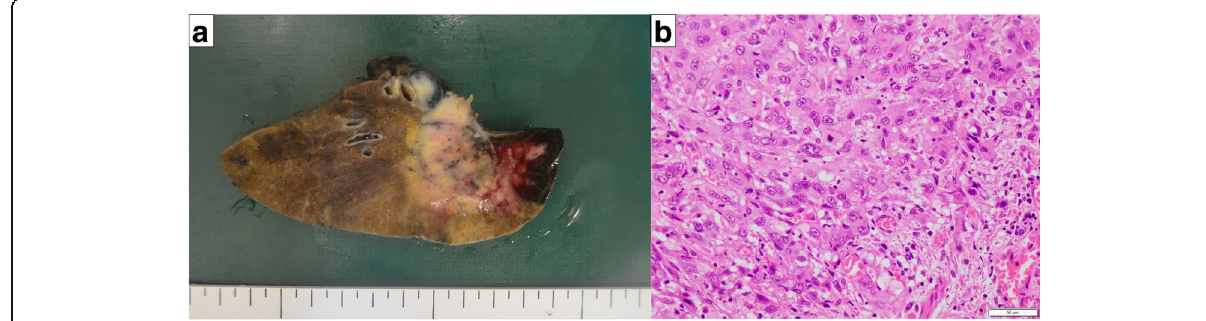
Fig. 2 Pathological findings. a Resected specimen showing a 6.6 cm × 4.3 cm-sized tumor in the left upper lobe . b Histological type was pleomorphic